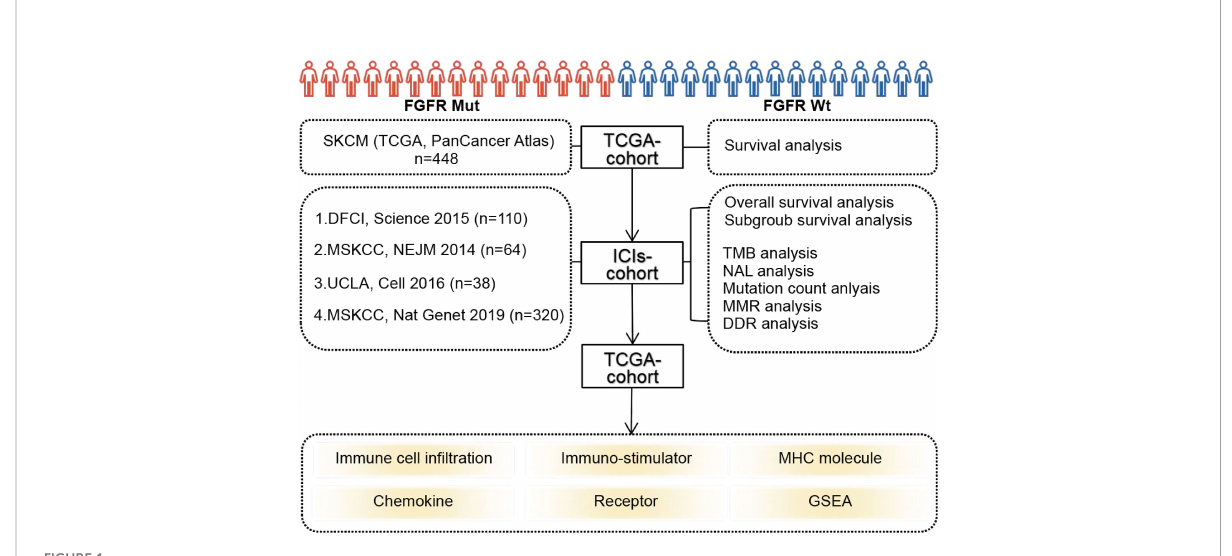
FIGURE 1 Flow diagram of the